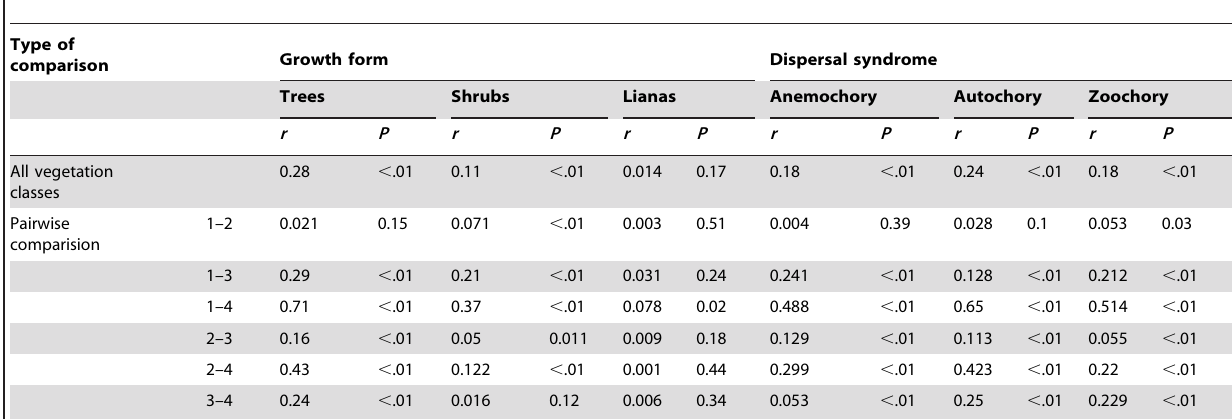
Table 2. Results of ANOSIM comparisons of community composition among vegetation classes by growth form and dispersal syndrome.